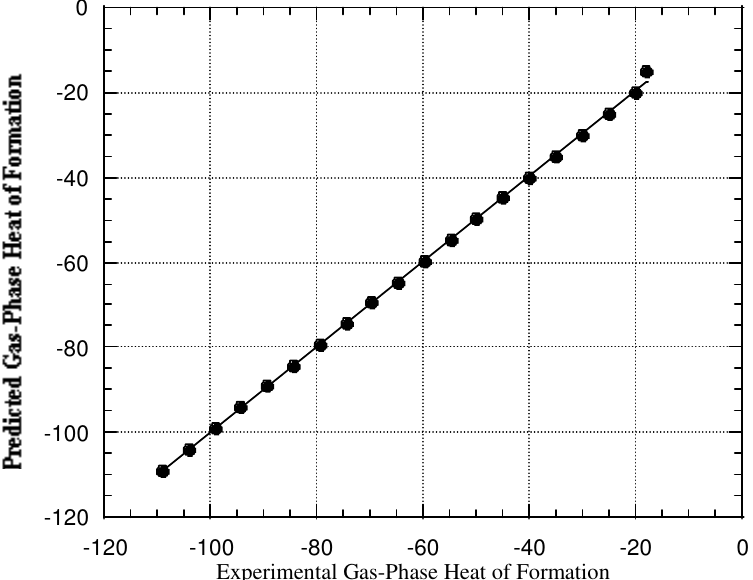
H° plotted against the experimental ∆ f gas H° = (-10.335 -0.00412 *V f gas H° (calc) = ∆ f gas